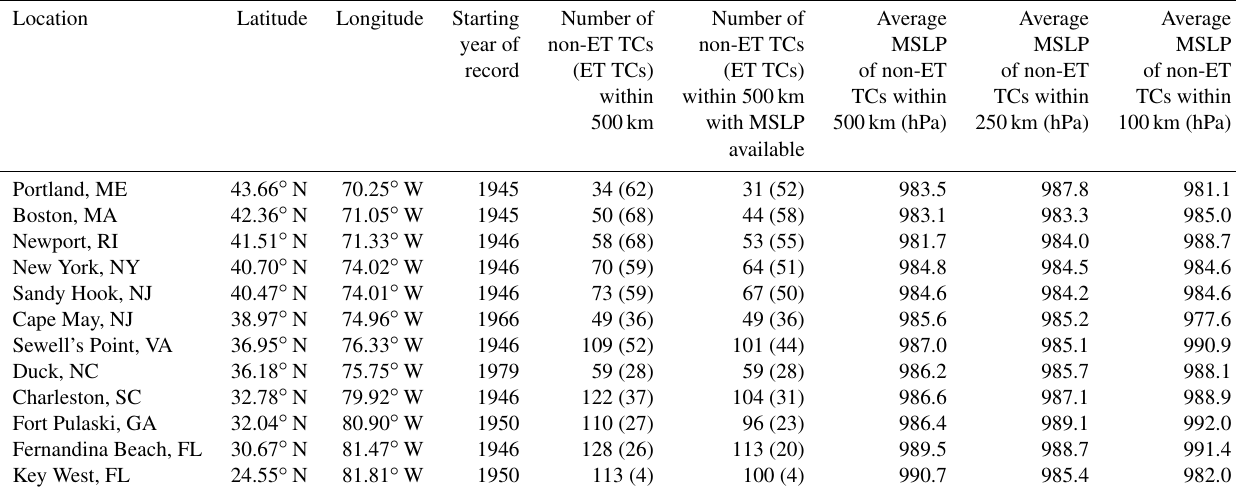
Table 1. Locations of tide gauges used in analysis with their location and length of data record, which spans through 2019 for all sites. TCs are separated based on whether they undergo extratropical transition (ET TCs) or do not (non-ET TCs). The number of TCs within 500km before and after the removal of missing MSLP values is included here. The average MSLP of TCs through the time-averaging technique within 500, 250, and 100km, which are referenced throughout the paper, is included